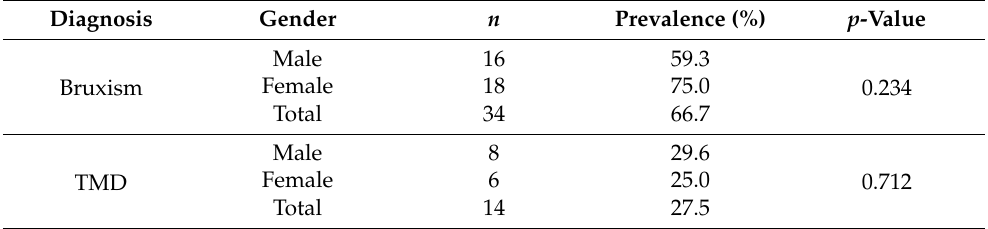
Table 1. Prevalence of bruxism and TMD by